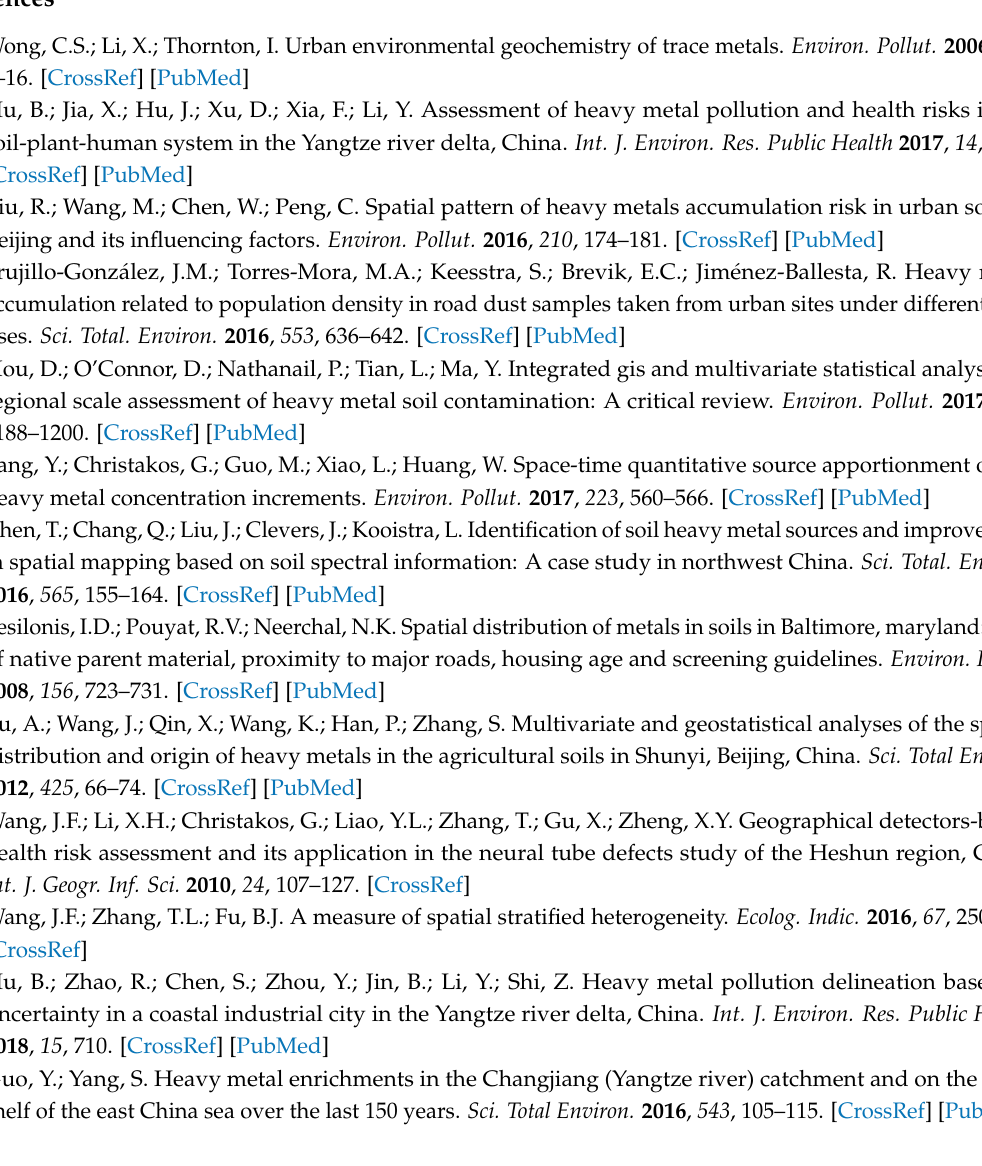
s1. Table S1: Source of the samples; Tabel S2: Operational parameters of the analysis by ICP-MS; Table S3: Background values (mg/kg) of eight heavy metals in Ningbo City in 1990; Figure S1: The FMPI soil texture and Food and Agriculture Organization (FAO90) soil type from Harmonized World Soil Database, HWSD in study area; F2: The spatial distributions of pH, organic matter, NH 4+ and NO 3- -N during the urbanization gradients; Figure